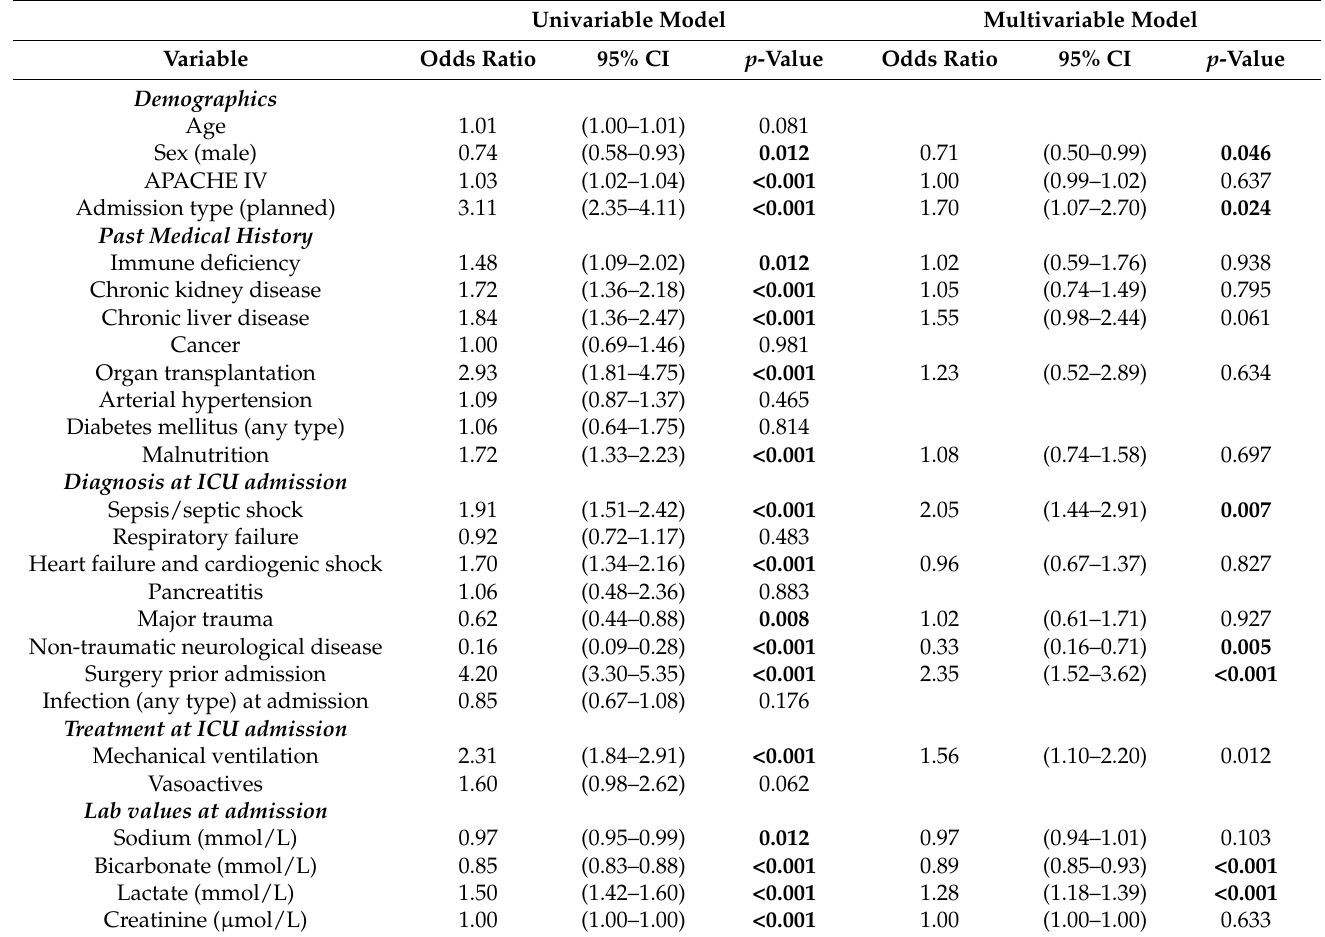
Table 1. Univariable and Multivariable Analysis for Fluid Overload at Day 3. Univariable Model Multivariable